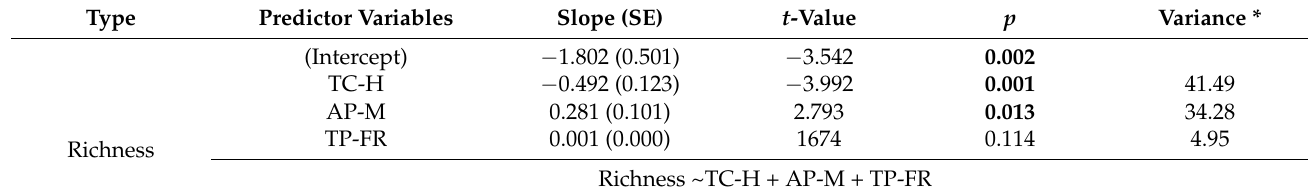
Table 3. Best AIC-selected linear regression model explaining the alpha diversity of EMF communities in poplar plantations grown under different N deposition ( n = 20) levels. TC-H, TC in humus layer; AP-M, AP in mineral soil; TP-FR, TP in fine roots; NH 4+ -M, NH 4+ in mineral soil; N/P-M, ratio of TN to TP in mineral soil. SE, standard error. Bold p -values indicate statistical significance at p < 0.05.